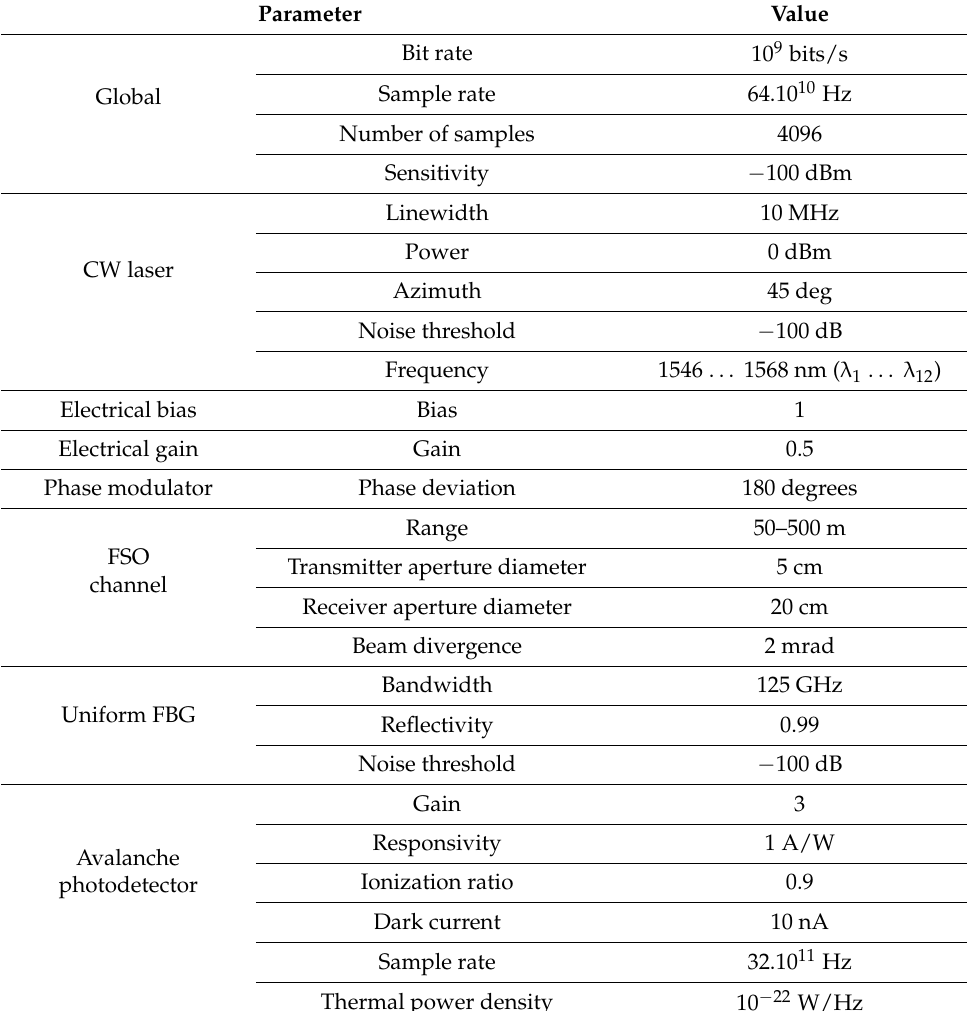
Table 2. Simulation